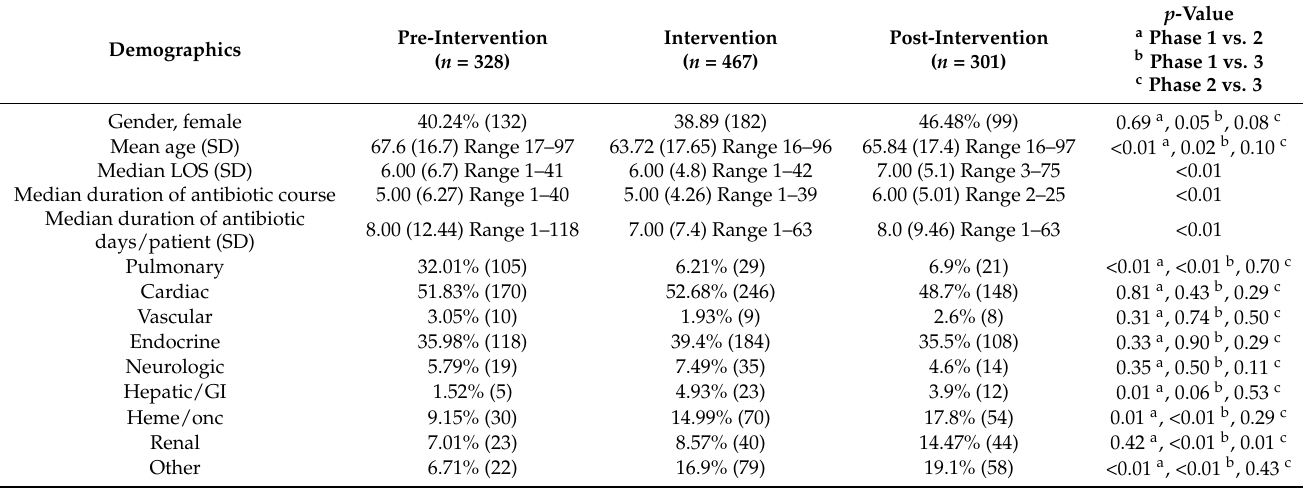
Table 1. Summary of demographic data and days of